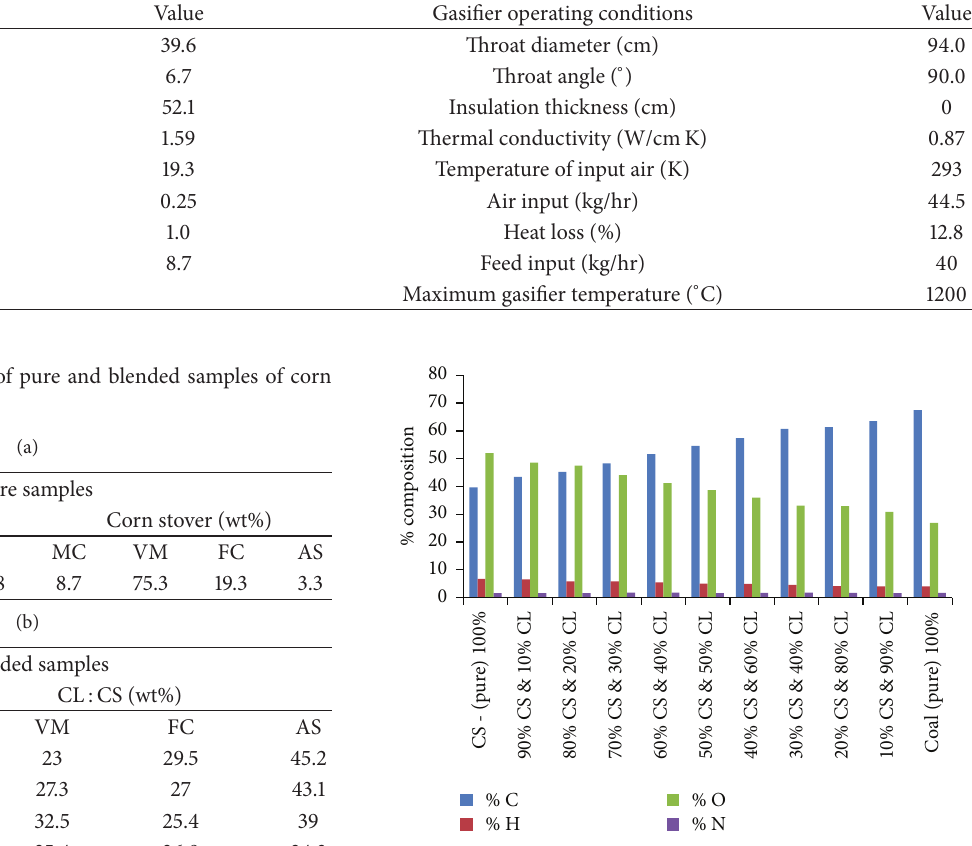
Figure 5: Ultimate analysis of pure and blended samples of corn stover and coal.